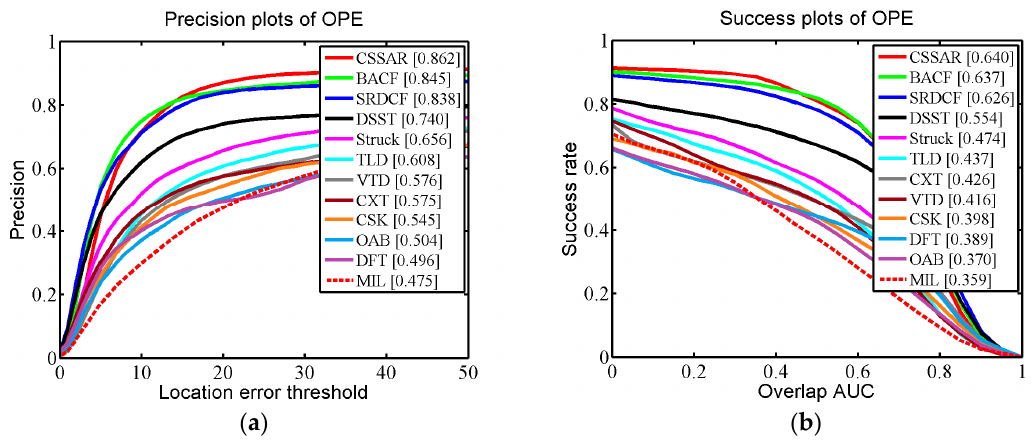
Figure 5. ( a ) reports the average distance precision score at 20 pixels for each method and ( b ) reports the success rate score calculated by the AUC on OTB which consists of 51 videos.